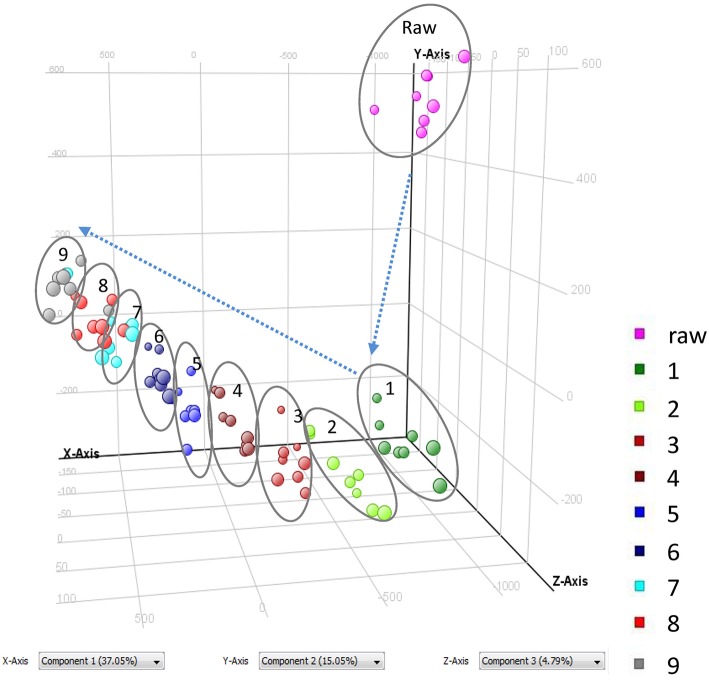
PCA score plots of RPMR and PPMR samples based on untargeted metabolomics analysis.